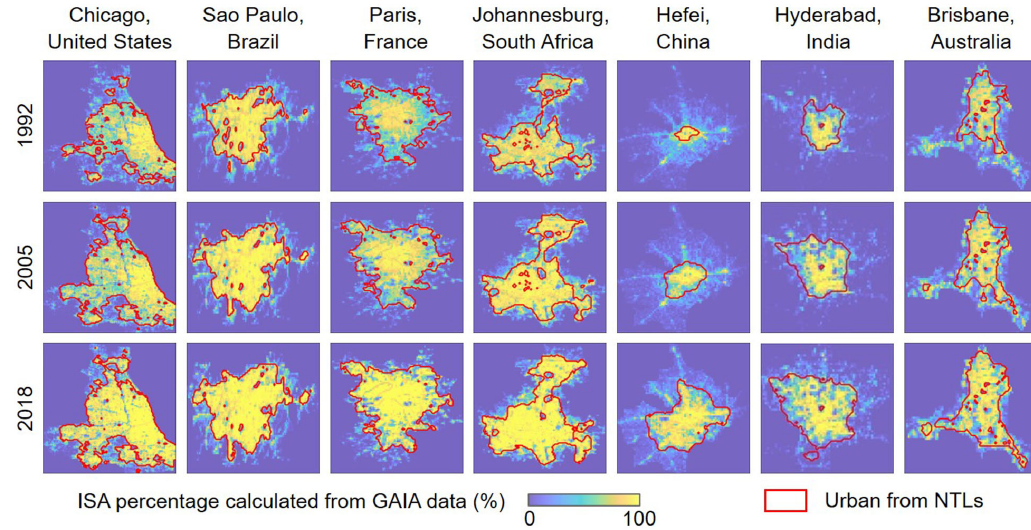
Figure 6. Comparisons of urban extent from NTL imagery with the ISA percentage map calculated from GAIA